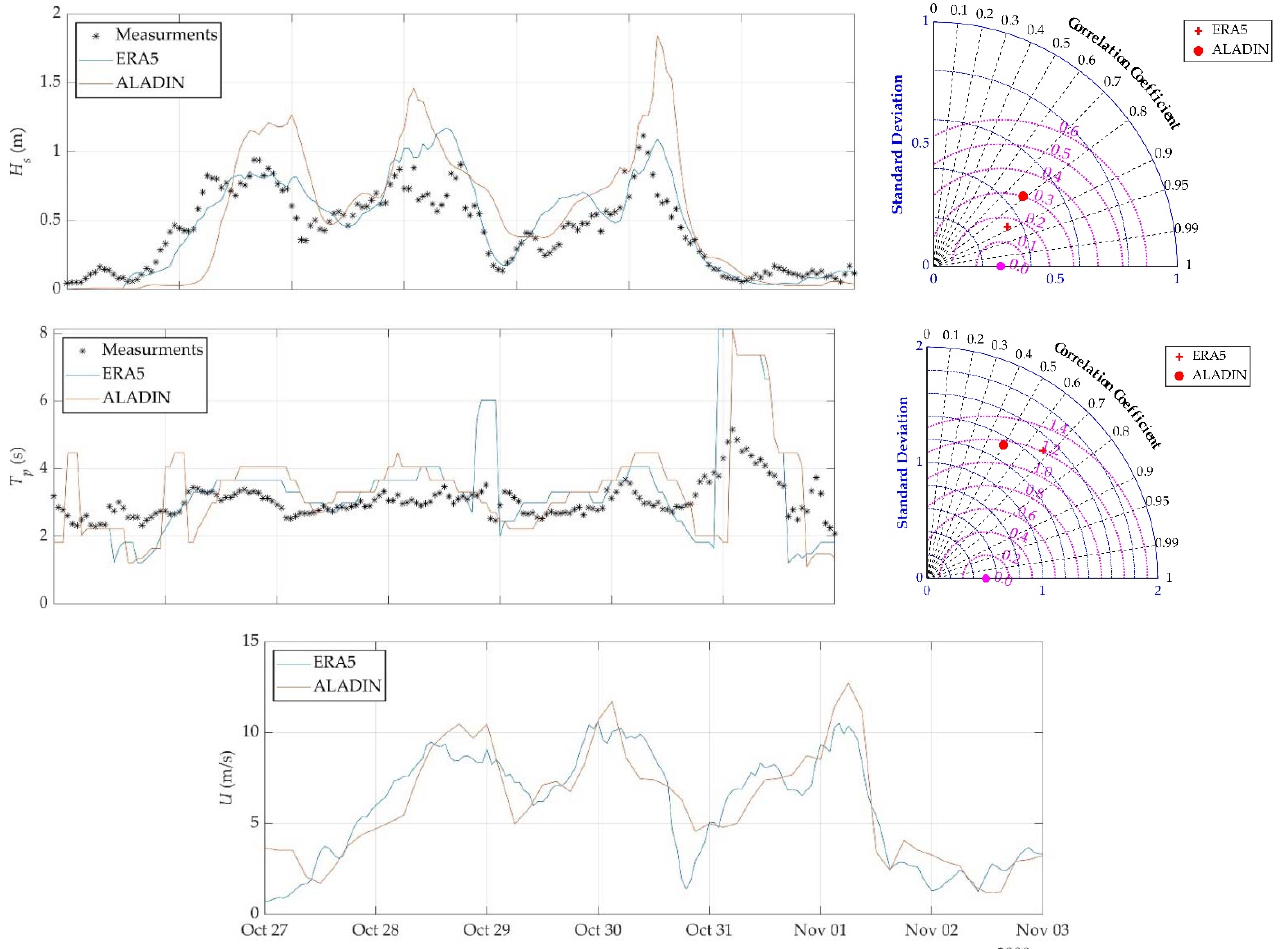
Figure 14. ( left ) Time series excerpt of measured wave parameters at wave buoy location in front of Figure 14. ( top left and middle left ) Time series excerpt of measured wave parameters at wave buoy Split (Figure 1) and modeled wave parameters forced by ERA5 and ALADIN wind products (wind location in front of Split (Figure 1) and modeled wave parameters forced by ERA5 and ALADIN field grids shown on Figure 5); and the time series of wind magnitude from reanalysis models ERA5 wind products (wind field grids shown on Figure 5); ( top right and middle right ) Taylor diagrams and ALADIN on the location of the wave buoy ( right ) Taylor diagrams showing statistical infor ‐ showing statistical information for the time series excerpts of significant wave height and peak wave mation for the time series excerpts. period; ( bottom ) time series of wind magnitude from reanalysis models ERA5 and ALADIN on the location of the wave buoy.